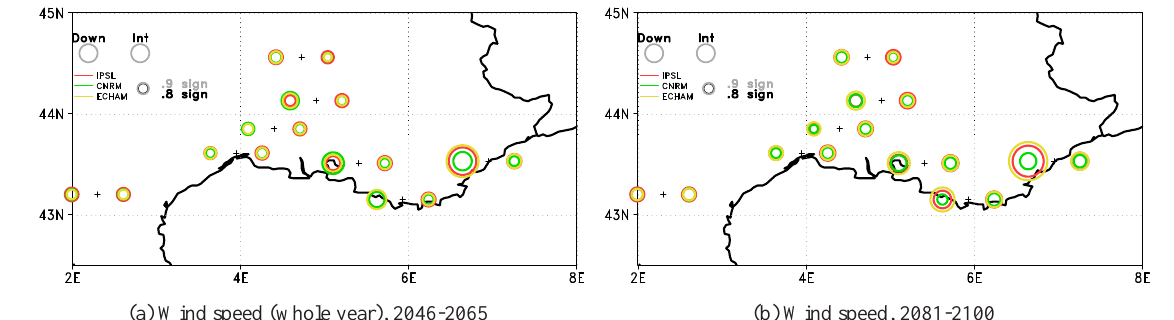
Fig. 8: Same as Fig. 6 for wind speed.